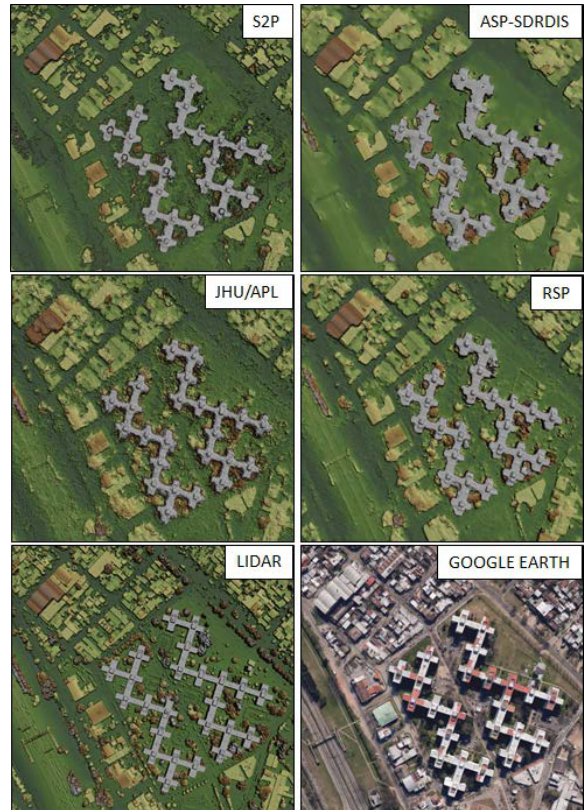
Figure 2 MVS and lidar point clouds are rendered as digital surface models and compared with Google Earth